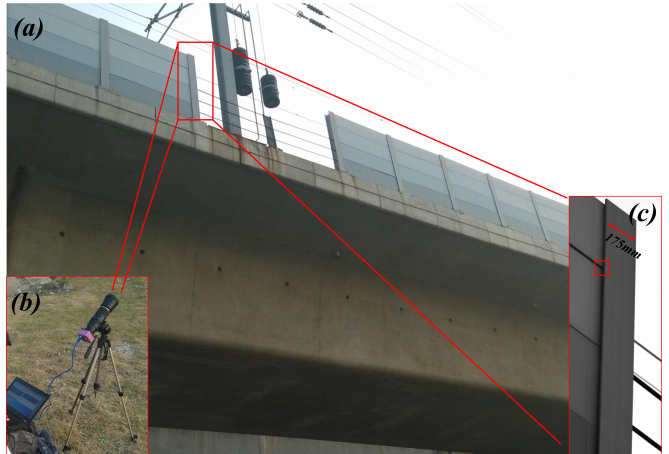
Figure 11. Sound barrier experiment setup: ( a ) the experiment environment; ( b ) experimental setup; ( c ) Image captured by the developed visual measuring